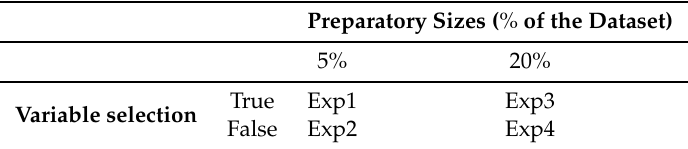
Table 2. The experimental benchmark for the comparison of the